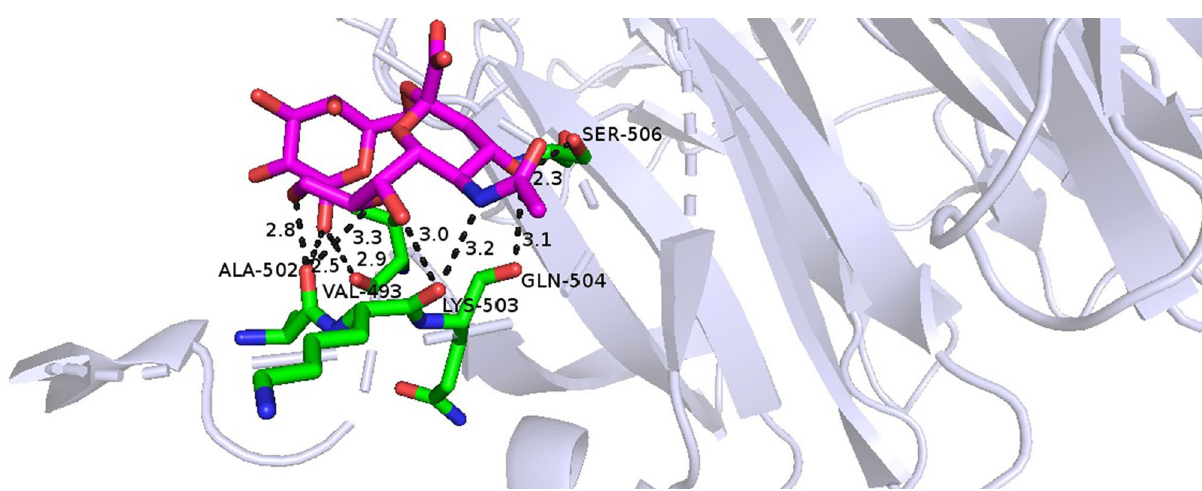
Figure 2. Visualization of interactions between Neu5Acα(2–6)Gal and NanB sialidase using Pymol showing hydrogen bonds, residues and their interaction distance with Neu5Acα(2–6)Gal in 3D.